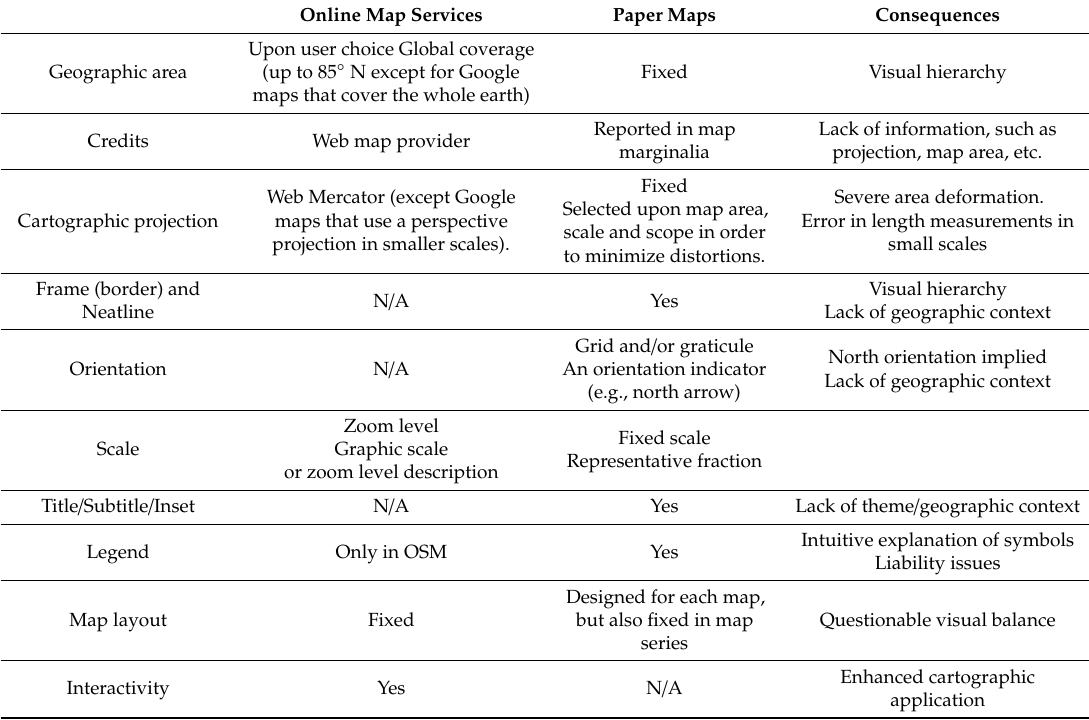
Table 2. Online map services elements in comparison with paper